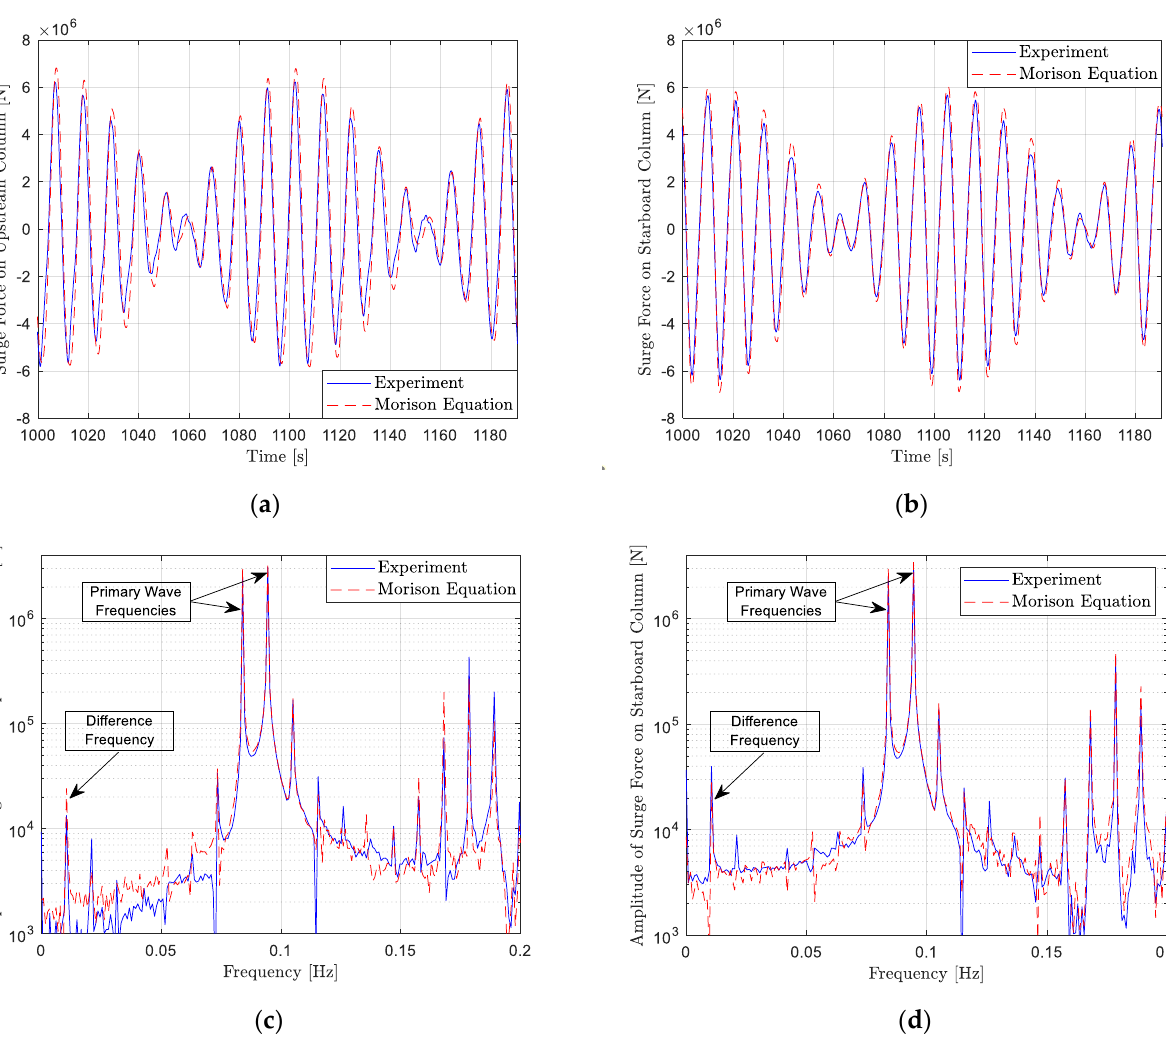
Figure 15. Comparison of full − scale surge − force time series ( a , b ) and amplitude spectra ( c , d ) from the experiment and the Morison equation. The results shown are for Configuration P (three columns with HP1 at zero pitch angle) in bichromatic wave B4. The surge force on the upstream column is shown in ( a , c ), and that on the starboard column in ( b , d ).